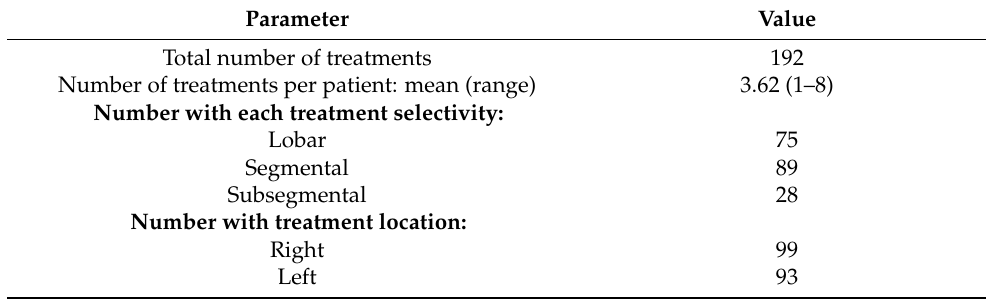
Table 2. Technical details of therapy with drug-eluting microspheres (100 µ m) loaded with irinotecan.